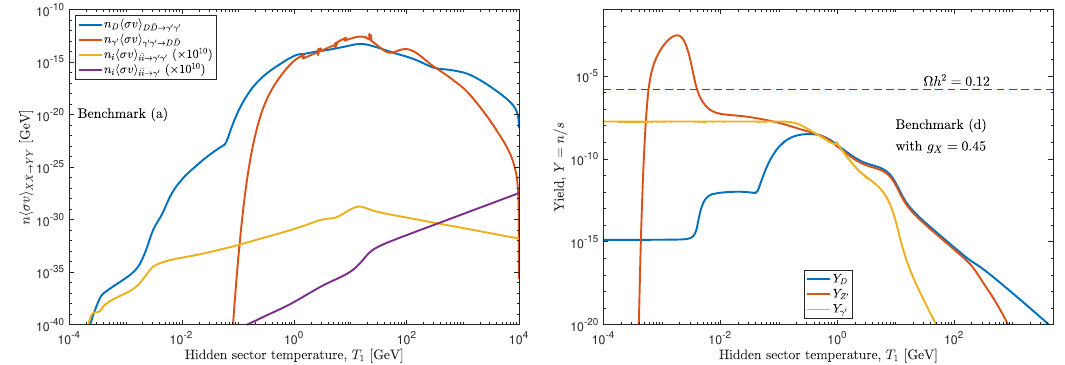
Figure 7 . Left panel: a plot of n h σv i for the processes contributing to the dark photon number density as a function of T 1 . Right panel: the yields of the hidden sector particles showing a diminishing Y γ 0 due to a smaller g X for benchmark